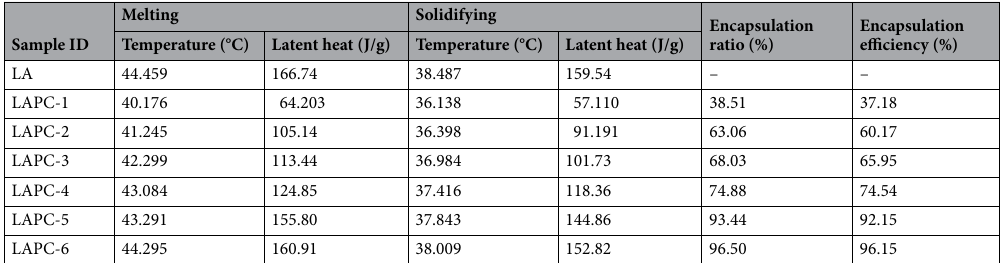
Table 3. DSC of LA and microencapsulated LA/SiO 2 .